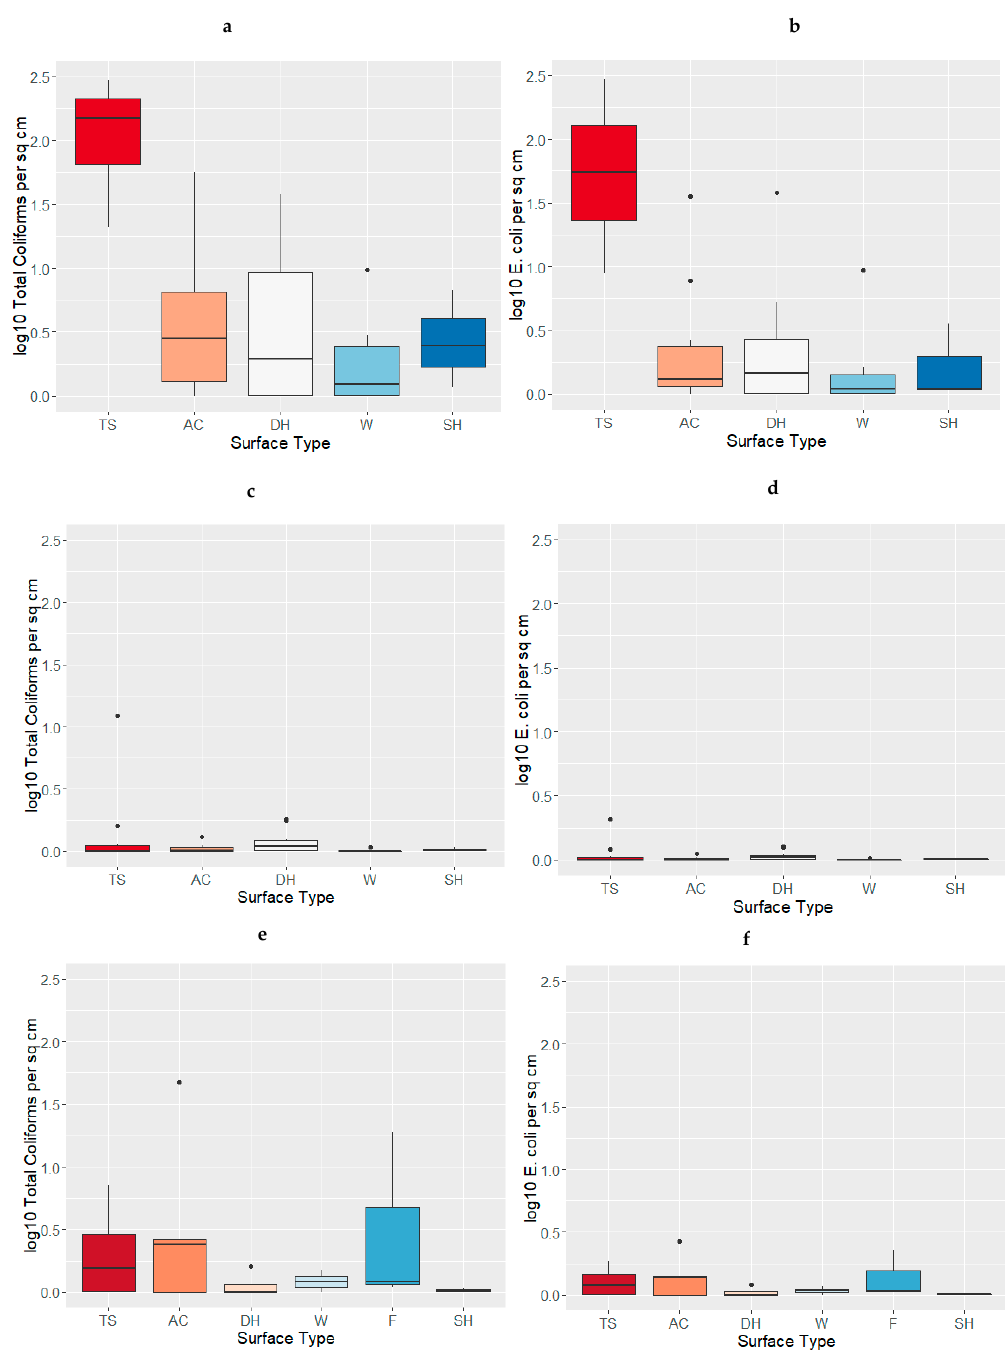
Figure 1. Bacterial Concentrations by Surface Type for Household and Community Latrines (boxplots represent median, 5% and 95% quartiles, range, and potential outliers). ( a ) Total Coliforms by Surface Type for Community Latrines under “Dirty” Conditions; ( b ) Escherichia coli ( E. coli ) by Surface Type for Community Latrines under “Dirty” Conditions; ( c ) Total Coliforms by Surface Type Community Sites under “Clean” Conditions; ( d ) E. coli by Surface Type Community Sites under “Clean” Conditions; ( e ) Total Coliforms by Surface Type Household Sites; ( f ) E. coli by Surface Type Household Sites.